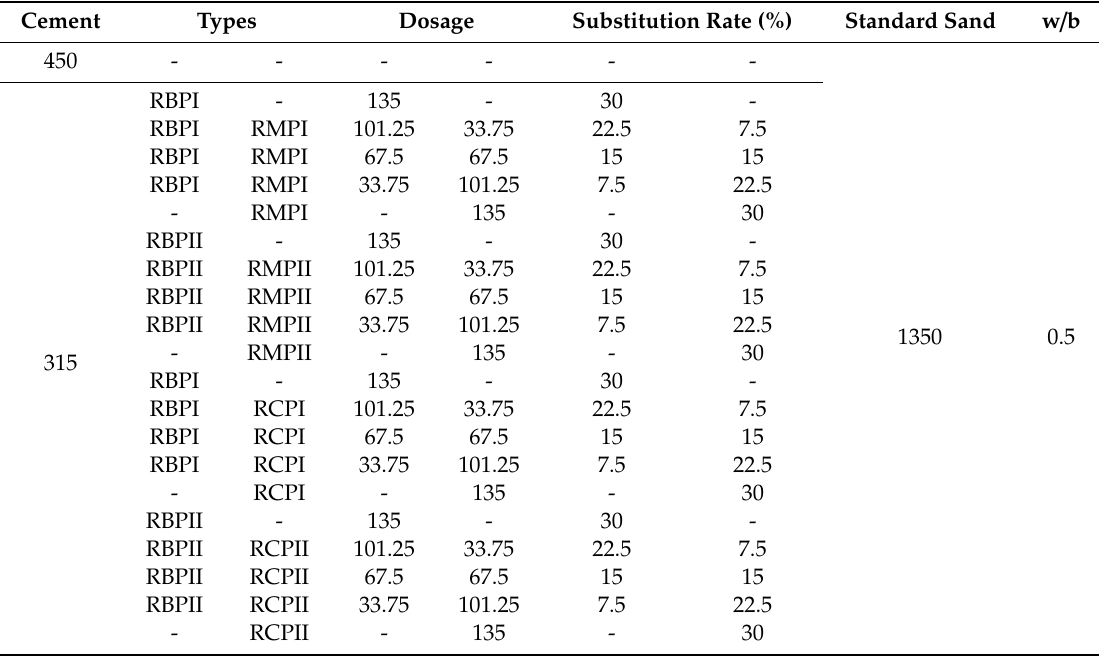
Table 4. Mixing proportions of mortar (kg · m − 3